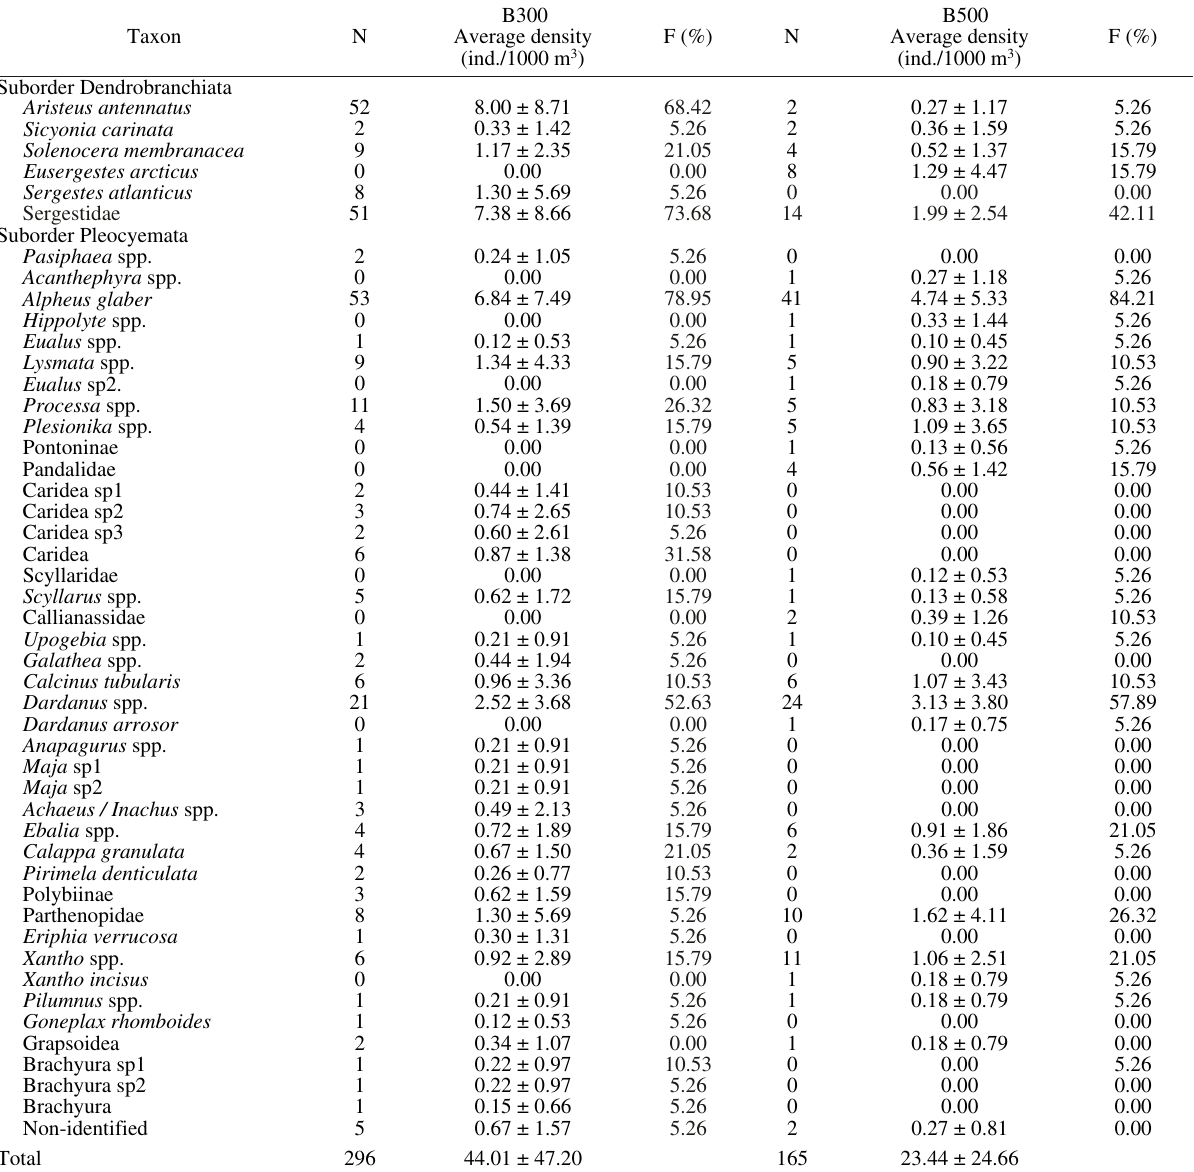
Table 3. – Total number (N), average density of individuals per 1000 m 3 with standard deviation and frequency (F) of decapod larvae caught with bongo